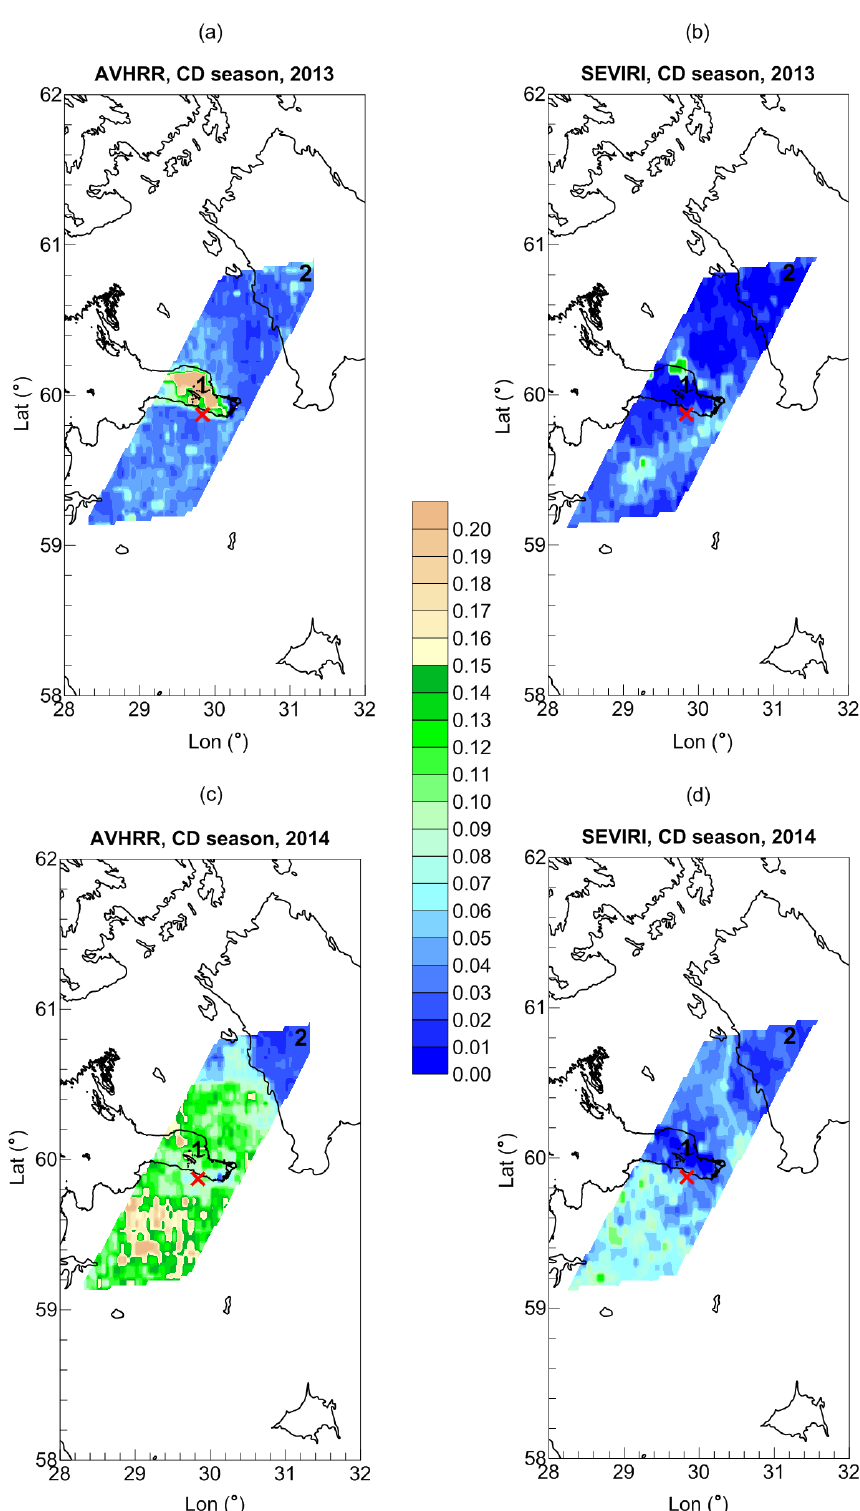
Figure 10. The maps of the mean LWP values (AVHRR and SEVIRI measurements, colour scale, kgm − 2 ) calculated for the large terrain for the CD season of 2013 (a, b) and 2014 (c, d) . The location of HATPRO radiometer is marked by the red cross. The black numbers identify the following objects: 1 – Neva Bay, 2 – Ladoga Lake. Vector shoreline data: GSHHG